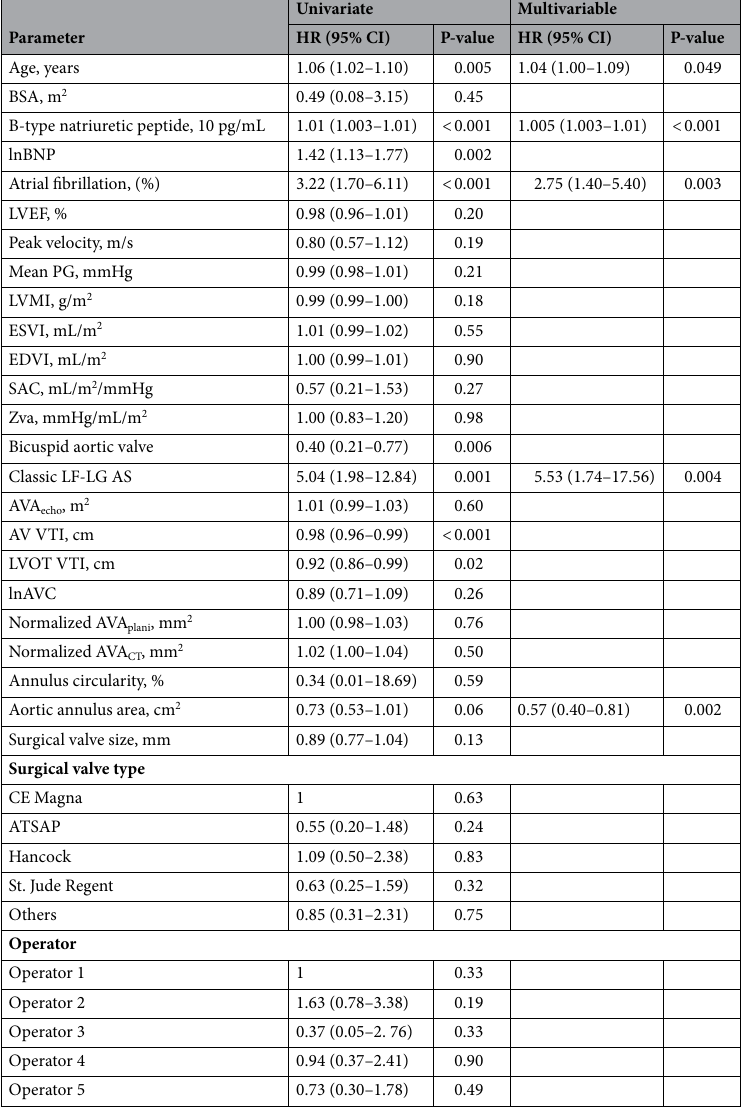
Table 3. Cox proportional hazard regression model for prediction of MACCE. AS aortic stenosis, AVA aortic valve area, AVC aortic valve calcium score, CI confidence interval, EDVI end-diastolic volume index, ESVI end-systolic volume index, HR hazard ratio, LF-LG low-flow and low-gradient, lnBNP log-transformed B-type natriuretic peptide, LVEF left ventricular ejection fraction, LVMI left ventricular mass index, LVOT left ventricular outflow tract, MACCE major adverse cardiac and cerebrovascular event, PG pressure gradient, SAC systemic arterial compliance, VTI velocity time integral, Zva valvulo-arterial